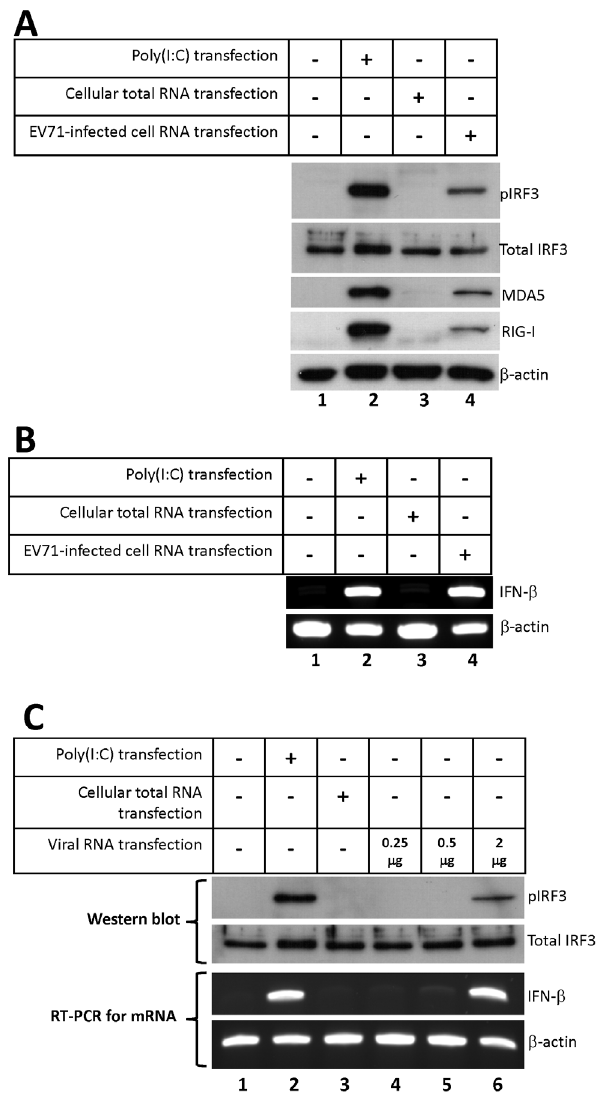
Figure 2. IRF3 is activated by EV71-derived RNA. (A) HeLa cells were transfected with 2 m g of poly(I:C), cellular total RNA of HeLa cells, or total RNA from EV71-infected HeLa cells for 20 h. The activation of IRF3 was analyzed by immunoblotting using anti-phospho-IRF3, anti- MDA5, anti-RIG-I, and anti- b -actin antibodies. Total IRF3 was also detected as a loading control. (B) HeLa cells were treated as described above. The total RNA from the transfected cells was collected and analyzed by RT-PCR for detecting IFN- b mRNA expression. (C) HeLa cells were transfected with 2 m g of poly(I:C), 2 m g of cellular RNA from mock- infected HeLa cells, or the indicated amount of EV71 viral RNA extracted from the supernatant of infected Vero cells for 20 h. The phosphory- lated IRF3 and total IRF3 were detected by immunoblotting. Total RNA from transfected cells was collected and IFN- b mRNA expression was evaluated using RT-PCR and agarose gel